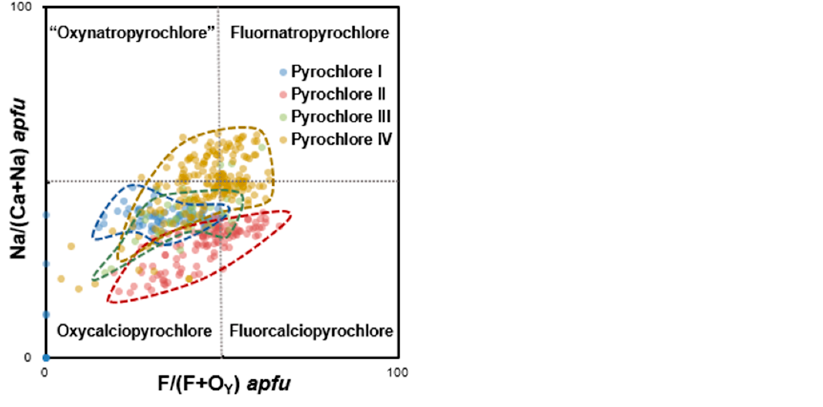
Figure 14. Compositional diagrams (atomic proportion) for the pyrochlore group minerals (pyro- chlores I, II, III, and IV) from the Baicao and Xiaoheiqing deposits.